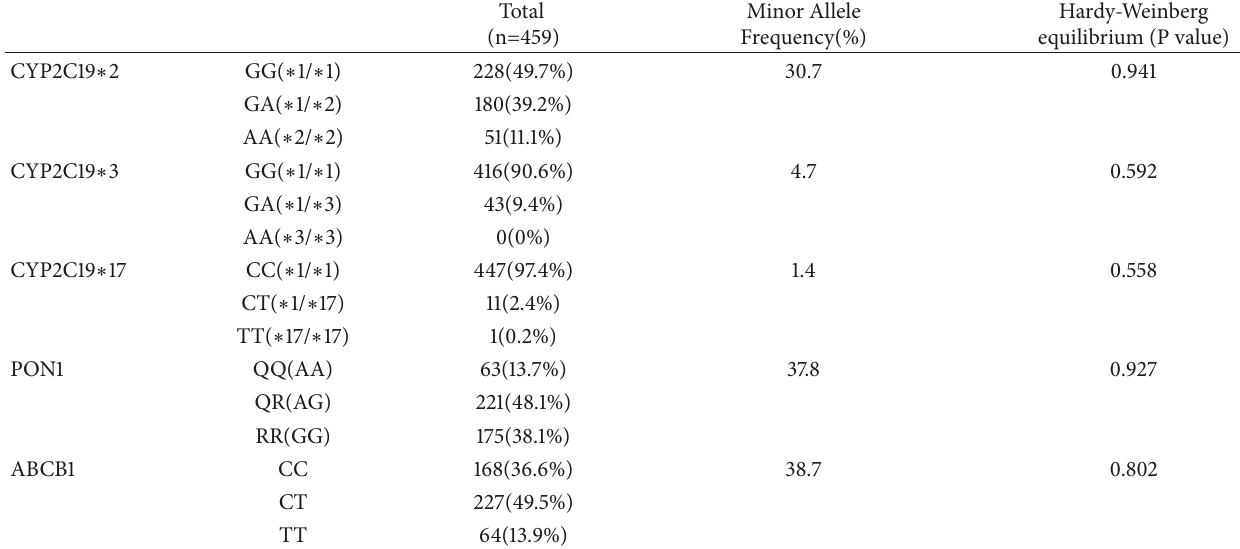
Table 2: Genotype distribution among the study population.